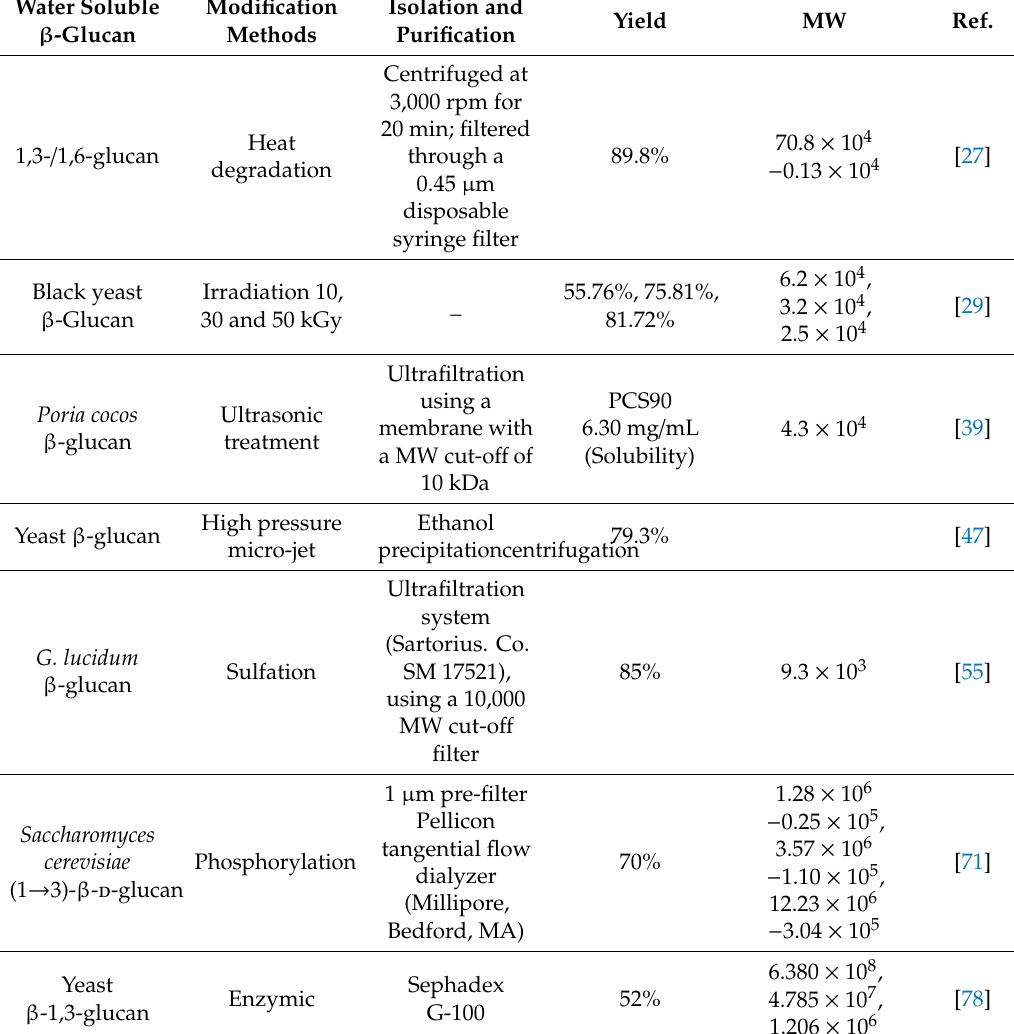
Table 1. Isolation and purification, water-soluble β -glucan yield and MWs produced by di ff erent modification